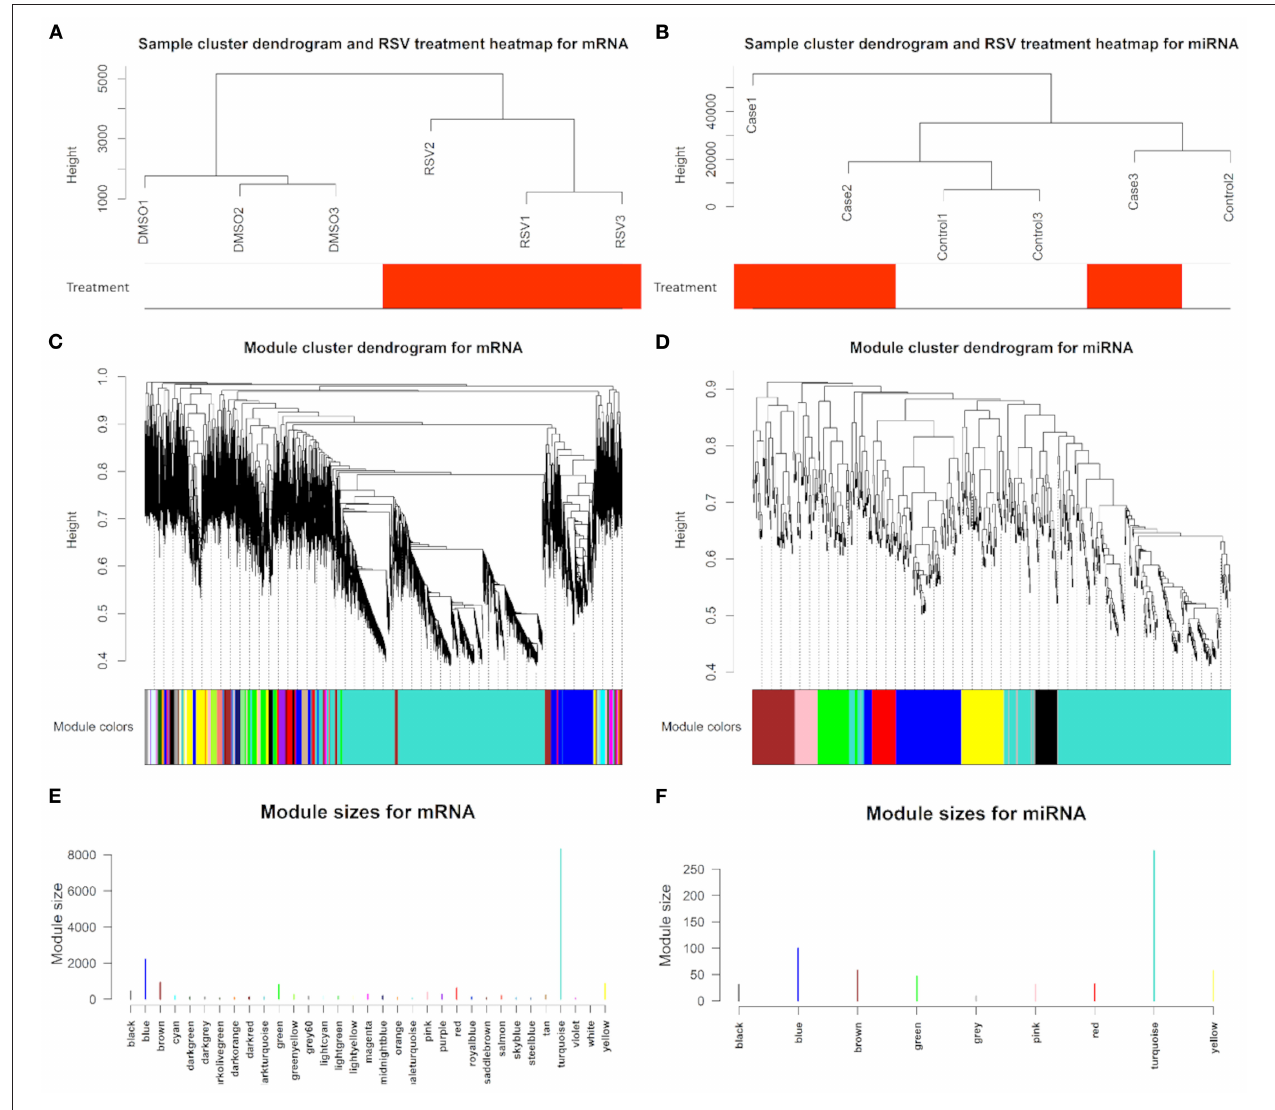
FIGURE 3 | Sample cluster with RSV treatment heatmap, dendrogram clustering plots with assigned module colors based on topological overlap analysis of dissimilarity, and identified module size in different colors for (A,C,E) mRNAs and (B,D,F) miRNAs, respectively.